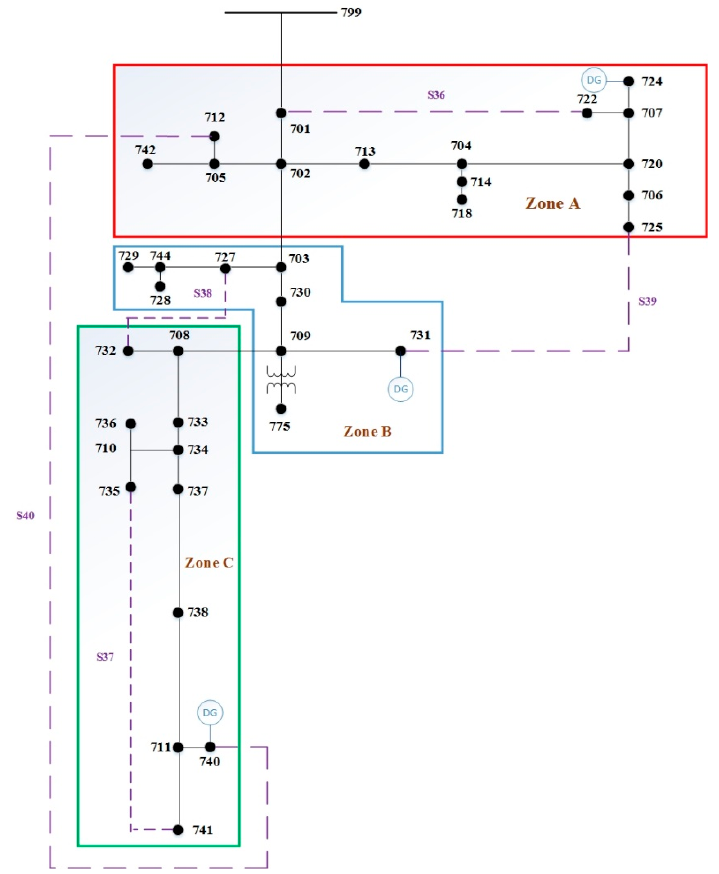
Figure 5. Single-line diagram of the sample system. Table 1. Parameters of tie switches and